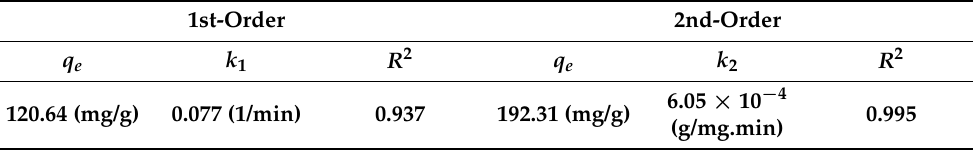
Table 3. ZrO 2 /CS adsorbent kinetic adsorption